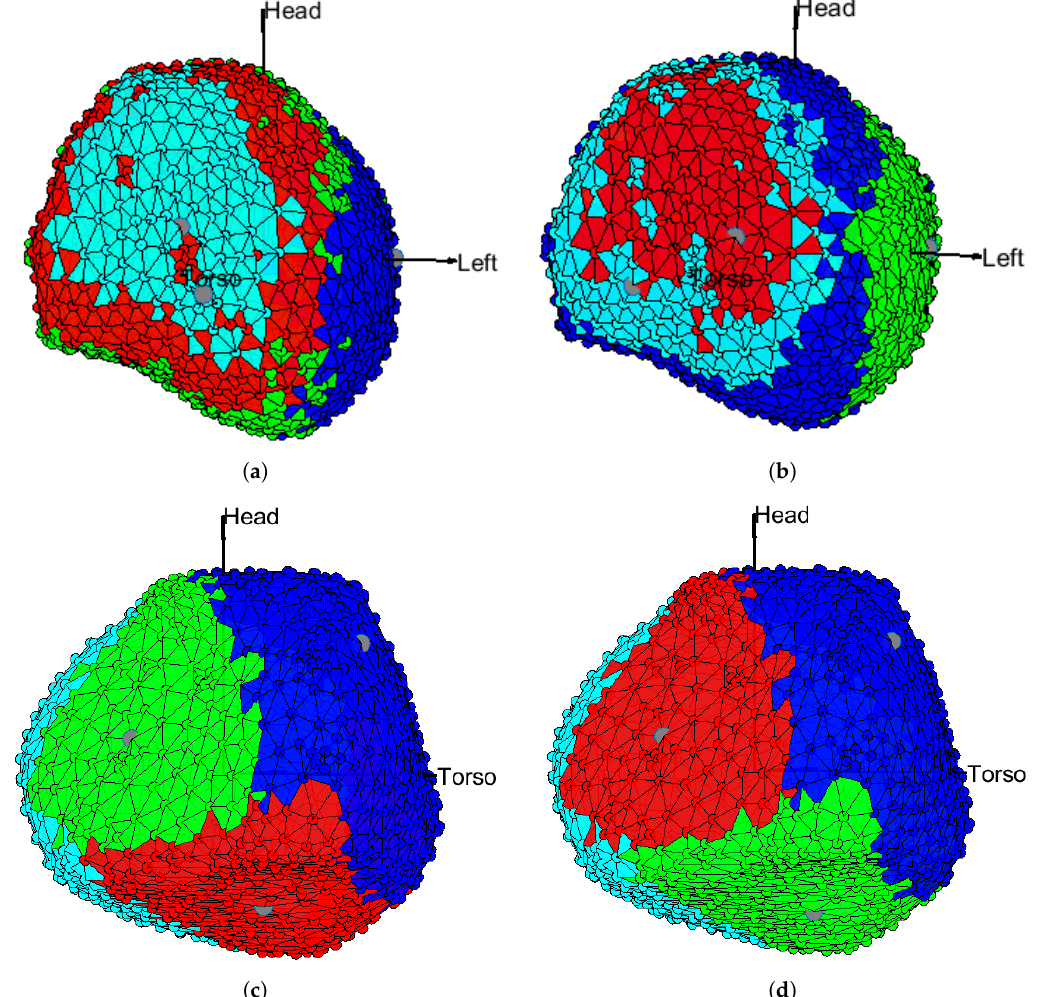
Figure 1. Unipolar Electrograms (EGM) in the presence of infarction. The distances used in the K -means algorithm with K = 4 were: ( a ) L 1 distance; ( b ) Euclidean distance; ( c ) cosine distance; ( d ) correlation